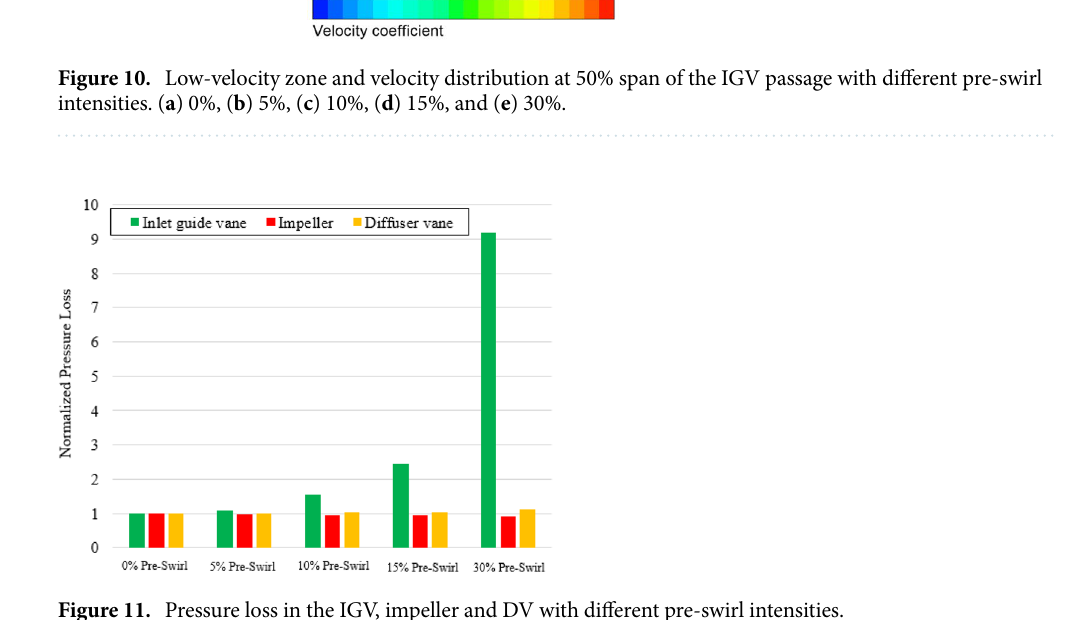
Figure 11. Pressure loss in the IGV, impeller and DV with different pre-swirl